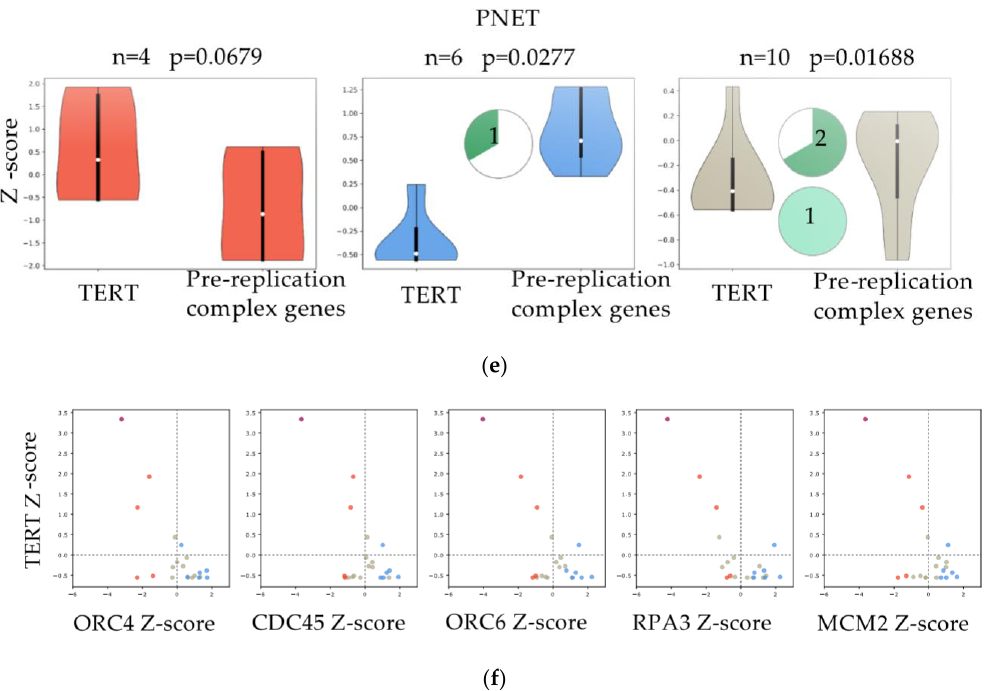
Figure 3. Correlation between the expression of genes of the pre-replicative complex and telomerase levels. ( a,c,e ) Violin plots comparing the expression of TERT and the mean expression of genes in the: “Activation of the pre-replicative complex” pathway in paediatric High Grade Glioma (pHGG), Medulloblastoma and PNET. Samples were divided into three groups by K-means clustering. Pie chart plots show the percentage of samples (actual numbers are indicated) with H3F3A (dark green) or ATRX (light green) mutations for each of the three groups. No mutational data were reported for MB. ( b,d,f ) Scatter plots of pHGG, Medulloblastoma and PNET showing the expression of TERT (y-axis, in Z-score) vs. the expression of five genes (ORC4, CDC45, ORC6, RPA3, and MCM2) in the: “Activation of the pre-replicative complex” pathway (x-axis, in Z-score). Samples marked in different colors belong to the three different groups as clustered by K-means.